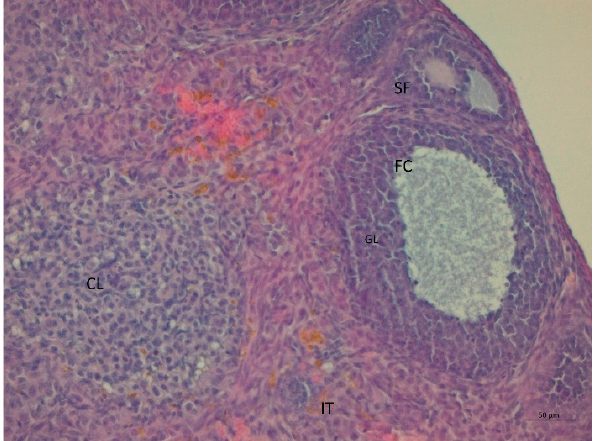
Figure 7. Histological sections of ovaries with follicular cysts (FC) in LET-treated mice. GL: granulosa cells; CL: corpus luteum; IT: interstitial tissue (H&E; power 200×).